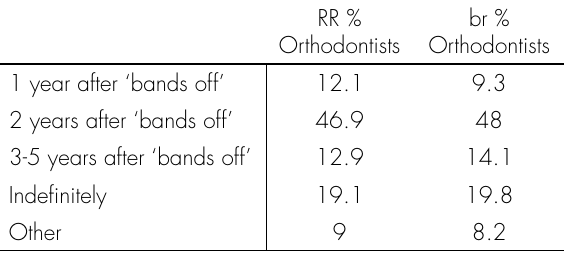
Table V. Length of time following comprehensive orthodontic treatment in which retainer checks are carried out by orthodontists.